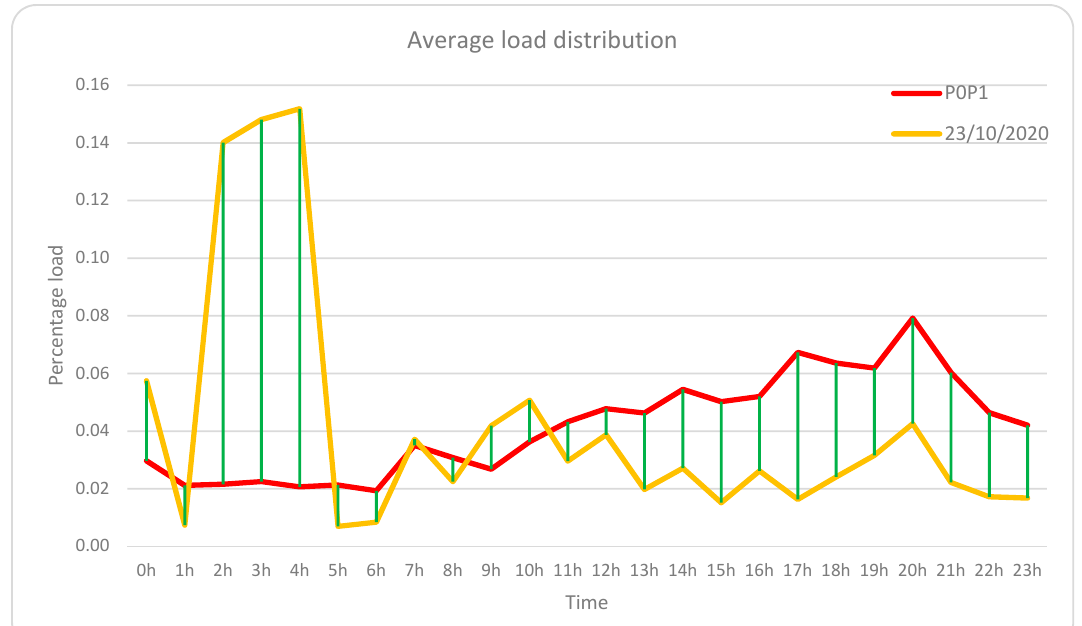
Figure 19. Average load distribution for each hour of the day and the scenario without load shifting or habit adaptation (P0P1 series). The load distribution for day 23 October 2020 has been added as an example to obtain the net load shifting.